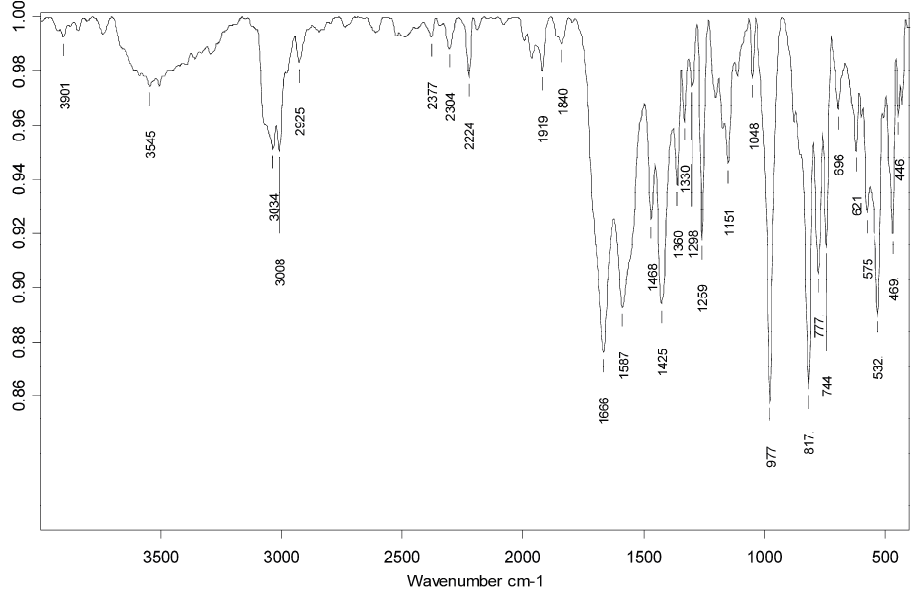
Figure 3. IR spectrum corresponding to trans- 4-(( E )-2-(pyridin-2-yl)vinyl)benzamido-TEMPO ( V